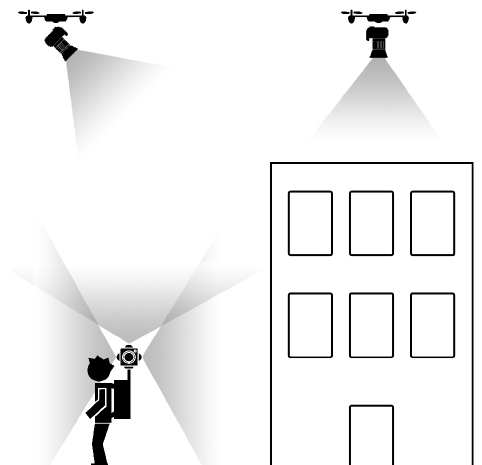
Figure 2. Simplified representation of the configuration of the three types of imagery used. Nadir UAV imagery, Oblique (45°) UAV imagery, and fisheye street-level imagery from mobile mapping system.